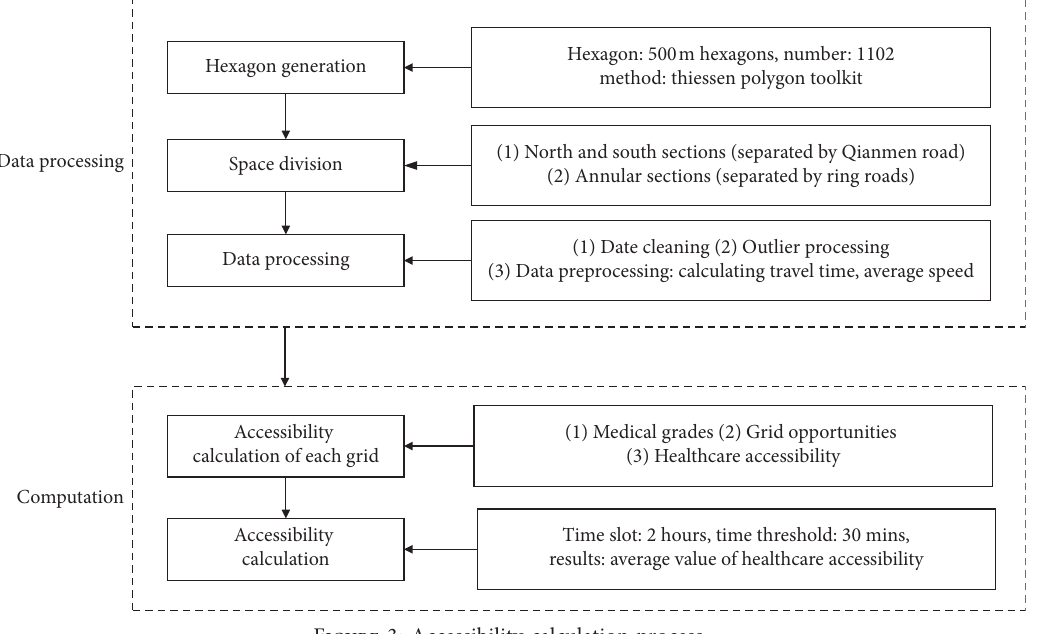
Figure 3: Accessibility calculation process.